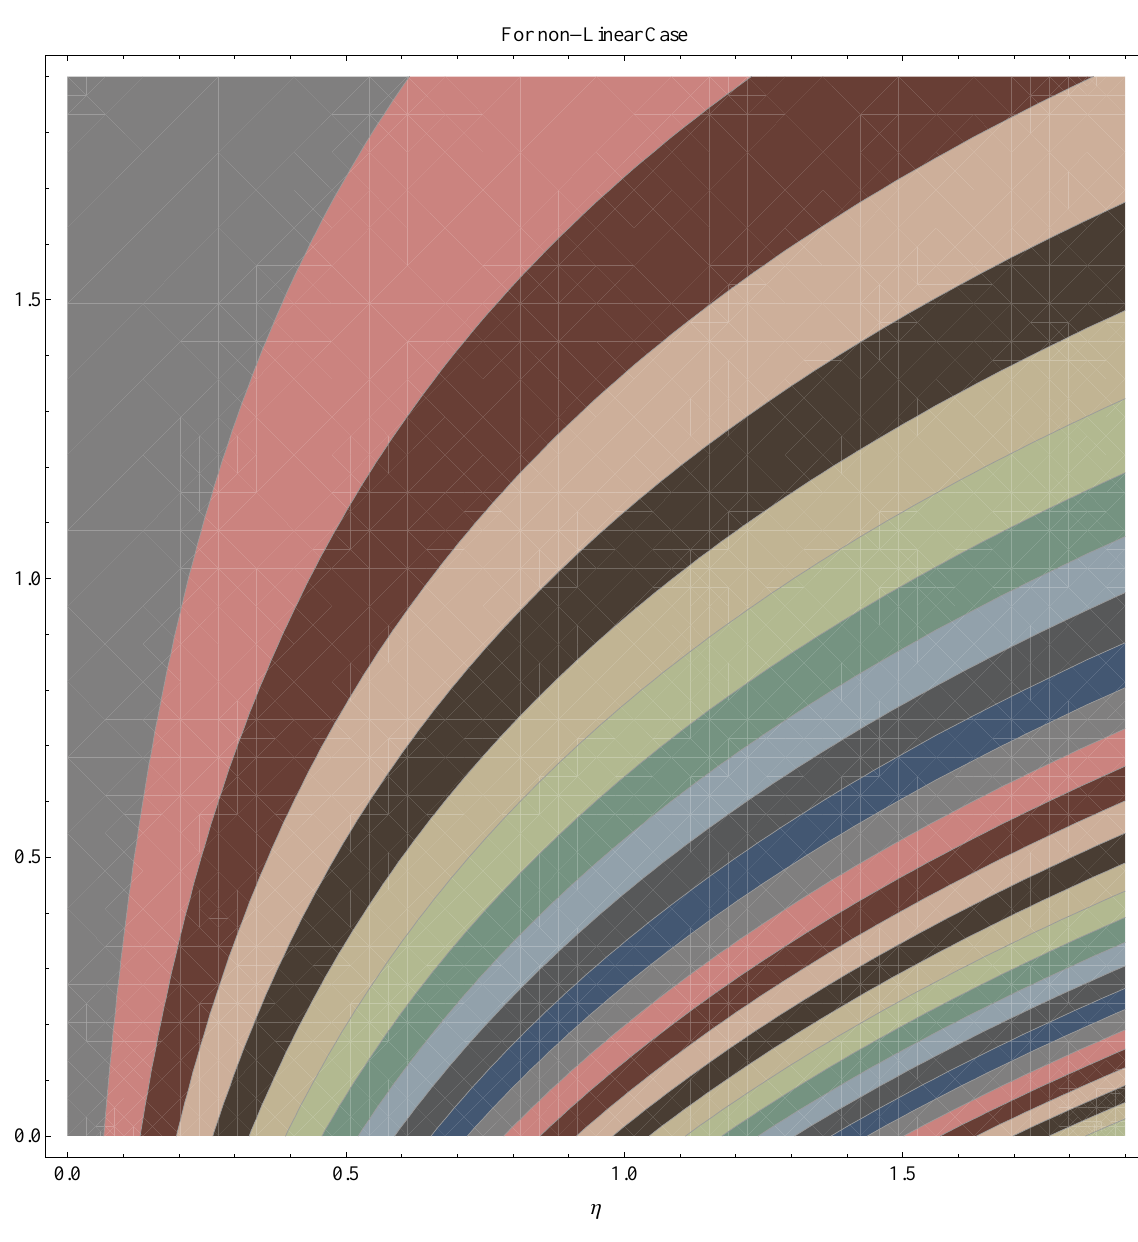
Figure 14. Contour graph for nonlinear